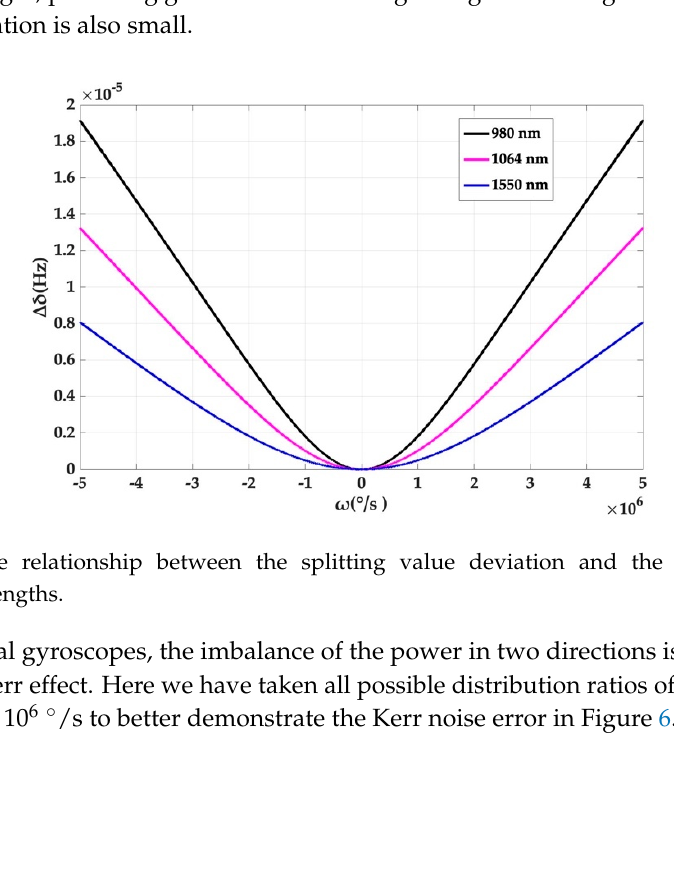
Figure 4. Splitting value deviation caused by Kerr noise at different angular rates.